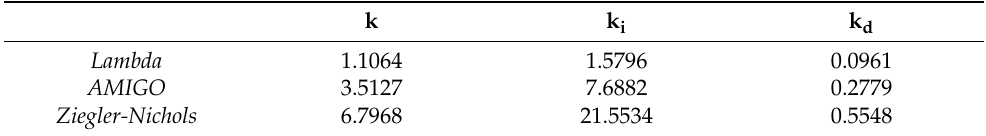
Table 4. Proportional-Integral and derivative (PID) parameters according to the average values from the step responses without any additional load.